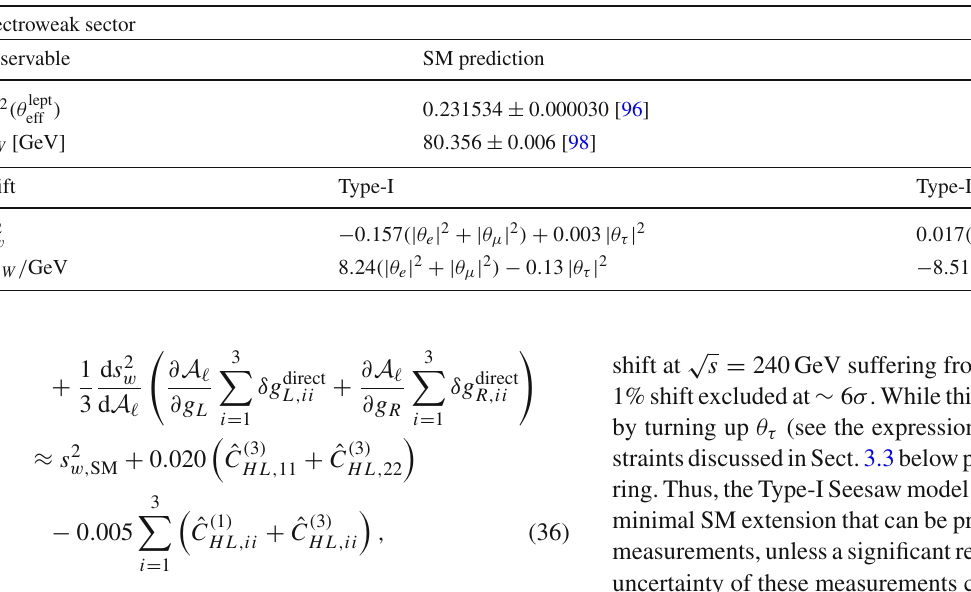
Table 5 SM predictions for and current measurements of the elec- troweakobservablesconsideredinthiswork,togetherwithapproximate expressions for their shifts in terms of the mixing angles. The W -boson mass listed in the PDG [98] corresponds to the mass parameter in a Breit–Wigner distribution with a mass-dependent width. The SM pre-